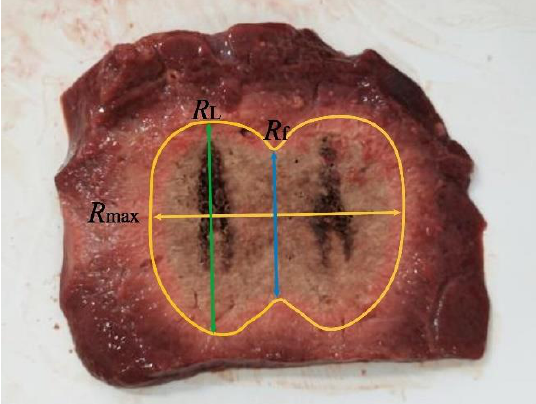
Figure 3. Schematic diagram of R max , R L , and R f in the fused coagulation